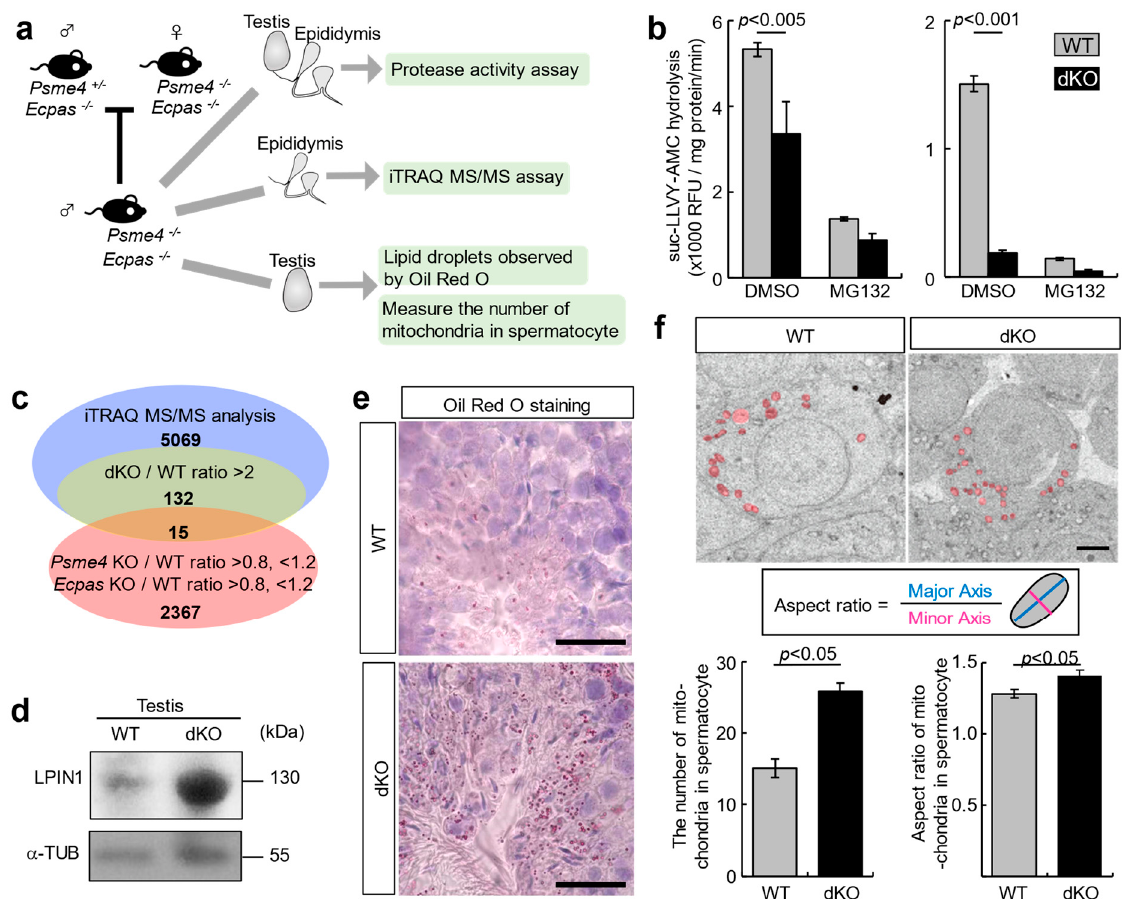
Figure 3. Impaired proteasome activity accumulates LPIN1 in the testes of Psme4/Ecpas double- knockout (dKO) mice: ( a ) Experimental flow of identification of target protein of proteasome involved with PA200 and ECPAS; ( b ) The chymotrypsin-like activities of the proteasome in the Psme4/Ecpas dKO testes (left) and epididymides (right) ( n = 3). MG132 effectively blocks the proteolytic activity of the 26S proteasome complex. Data are expressed as the mean ± standard error; ( c ) Detection of accumulated proteins in the Psme4/Ecpas dKO epididymides by iTRAQ MS/MS analysis; ( d ) Immunoblotting of LPIN1 in dKO testes; ( e ) Testicular sections stained with hematoxylin and eosin (HE) and Oil Red O; scale: 20 µm; ( f ) The appearance of mitochondria in dKO spermatocyte: (upper) transmission electron microscopy (TEM) images of mitochondria (red) in dKO spermatocyte; scale: 2 µm; (lower) the number of mitochondria ( n = 30) and the aspect ratio of mitochondria ( n = 45) in spermatocytes. Data are expressed as the mean ± standard error.